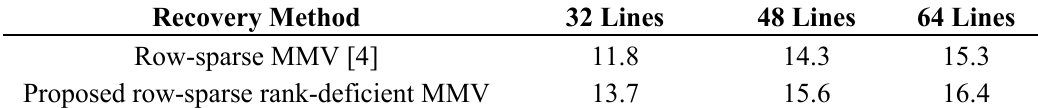
Table 1. Ex vivo : SNR for same Fourier mapping with all echoes.